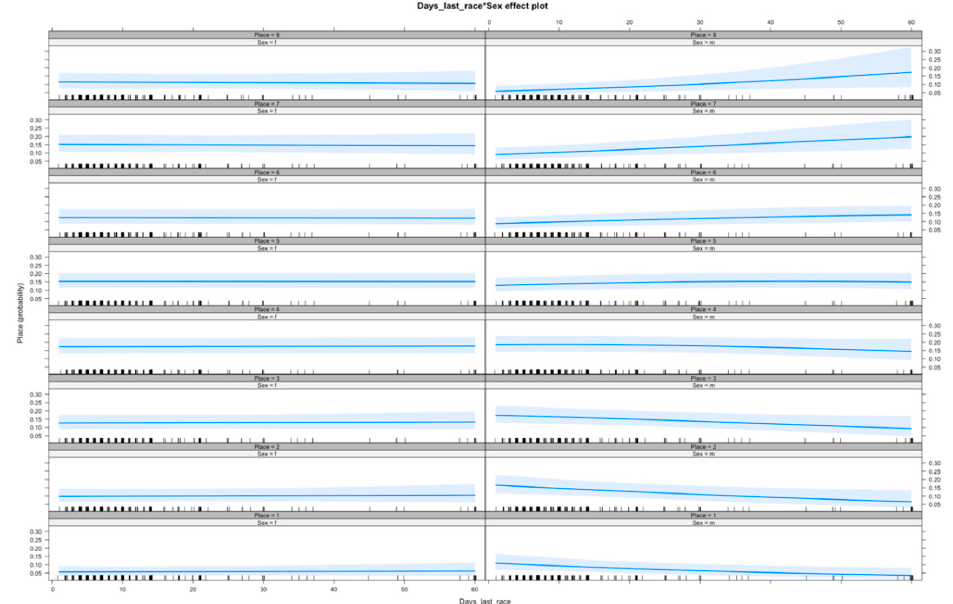
Figure 1. The effects of days since last raced (x-axis) on the probability of placing (place 1st–8th) for females (left column) and males (right column). There was an interaction between sex and days since last raced, with males more likely to place poorly as intervals since last racing increased. Confidence intervals (95%) shown in shading.